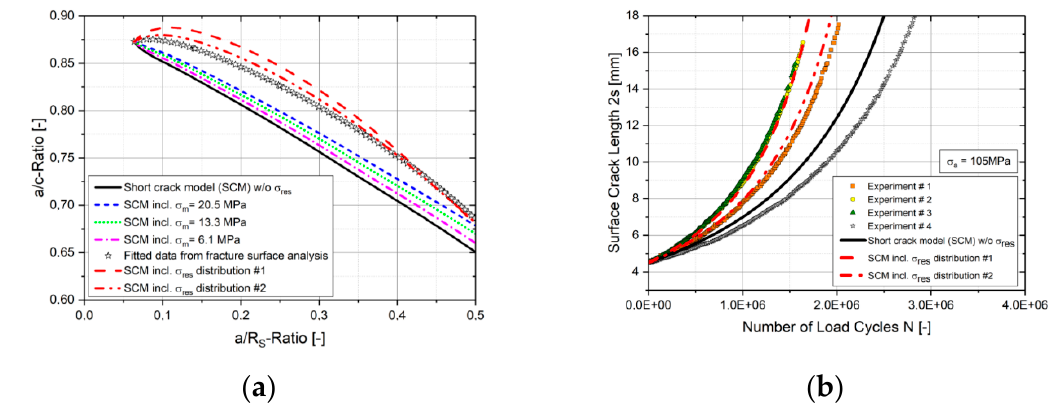
Figure 14. ( a ) Influence of residual stress distributions on crack shape evolution; ( b ) and residual lifetime.